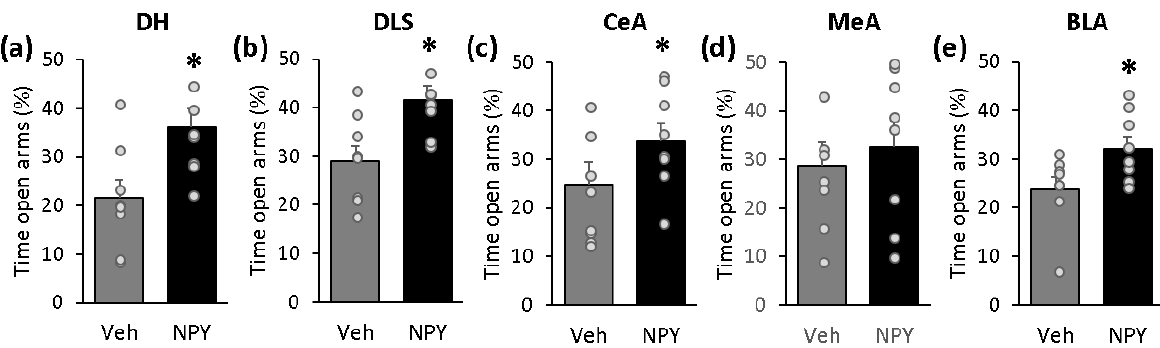
Figure 4. NPY exerts anxiolytic-like effects when administered into the dorsal hippocampus ( a ), dorsolateral septum ( b ), central amygdala ( c ) and basolateral amygdala ( e ), but not when administered into the medial amygdala ( d ). Mice ( n = 8 per group for each brain region) were administered either vehicle (Veh; 0.2 µ L/side) or NPY (0.1 nmol/0.2 µ L/side) 10 min before being tested on the elevated plus-maze. Data represent means + SEM. p < 0.05 * vs. Veh-treated mice.